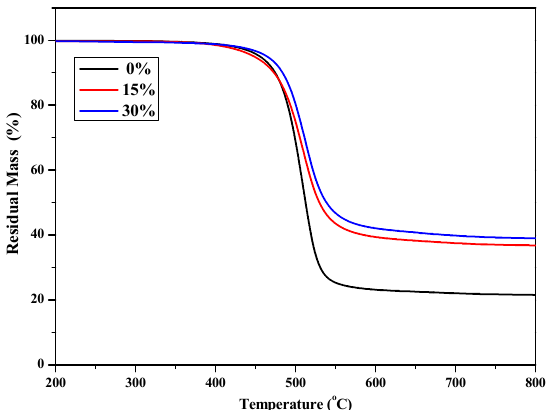
Figure 3. The TGA curves of cured P(4-MB-co-1-MP) and P(4-MB-co-1-MP)/BCB-POSS resins.